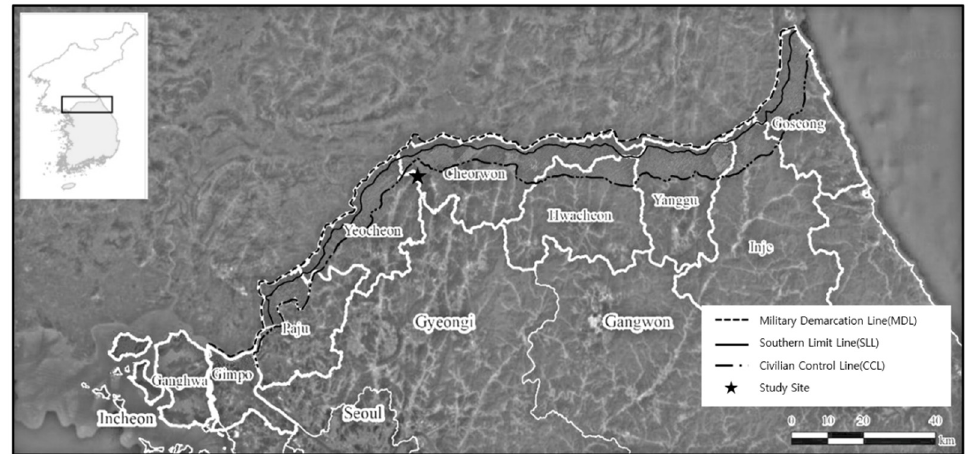
Figure 1. Map of the study site showing the location of the military demarcation line (MDL), southern limit line (SLL), and civilian control line (CCL). The civilian control zone is located between the SLL and CCL. The border line (BL) is the zone within 25 km of the CCL (modified from Lee’s map